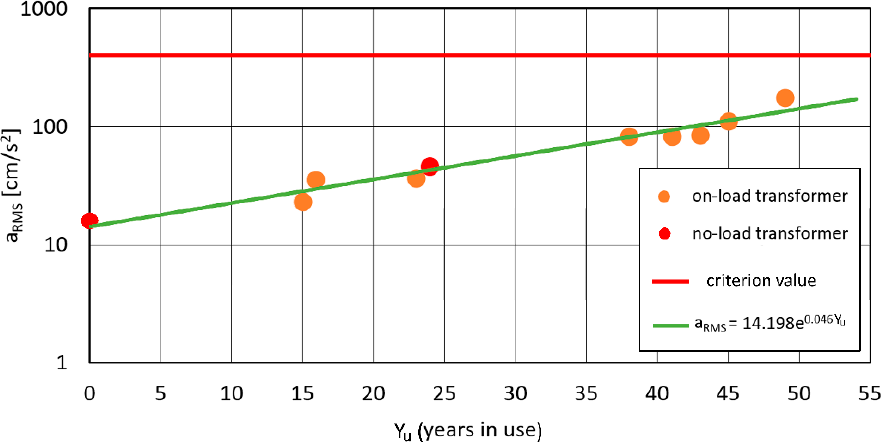
Figure 9. Averaged root mean square values of vibration acceleration from 6 measurements points for 16 MVA transformers depending on the age of the unit.